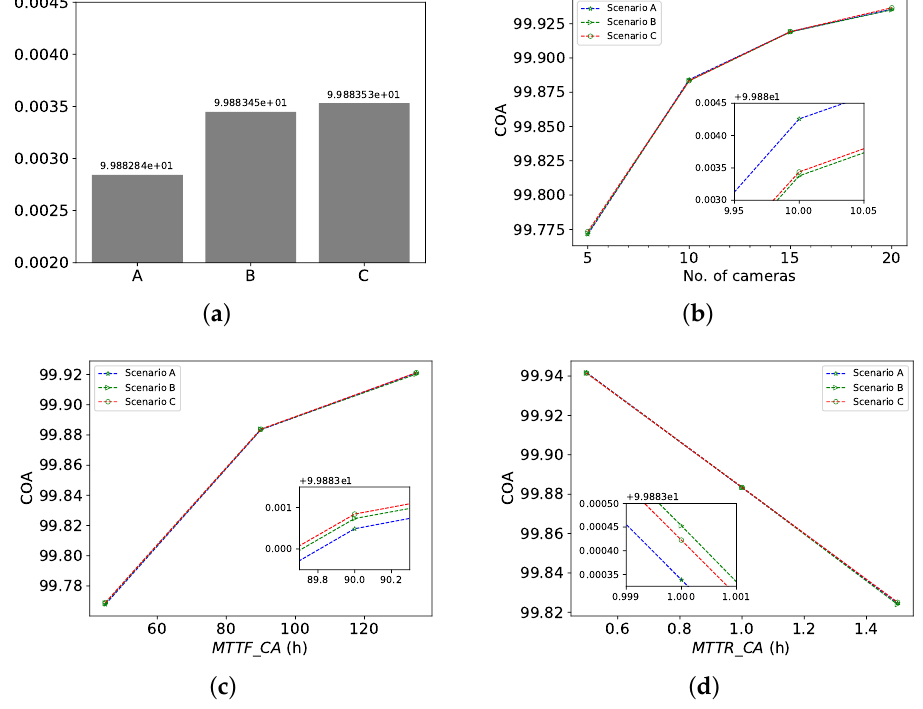
Figure 11. Capacity-oriented availability of a surveillance system: ( a ) COA under default parameters; ( b ) COA with respect to the number of cameras; ( c ) COA with respect to MTTF_CA ; and ( d ) COA with respect to MTTR_CA